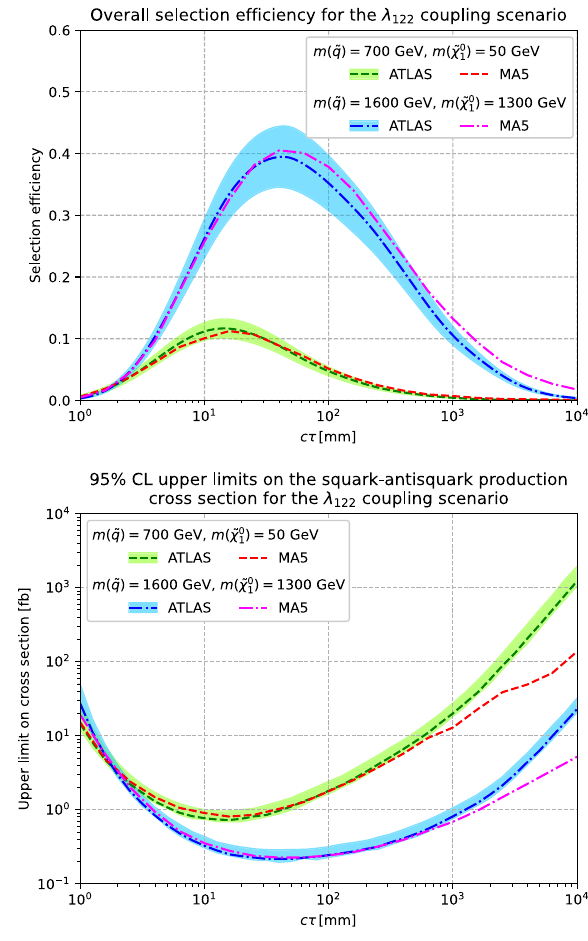
Fig. 4 Overall selection efficiencies (top) and upper limits on the squark-antisquark production cross section (bottom) obtained with our MadAnalysis 5 implementation (MA5), in comparison with the lim-